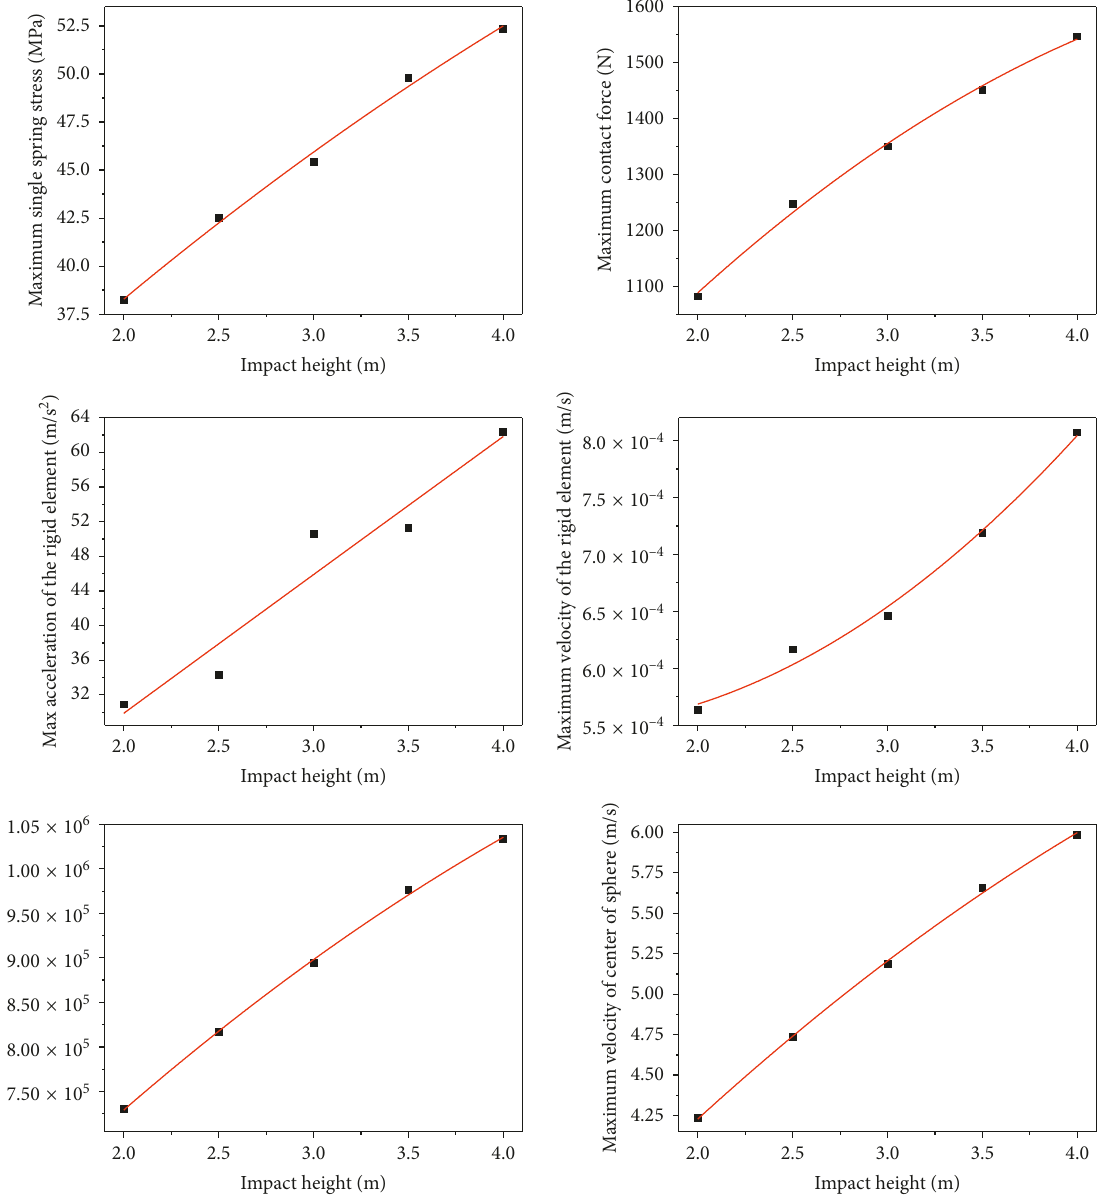
Figure 22: Maximum contact